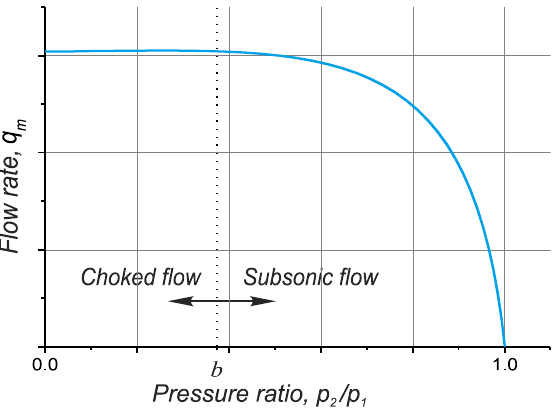
Figure 13. Theoretical flow-rate characteristic according to ISO 6358 and JIS B 8390.